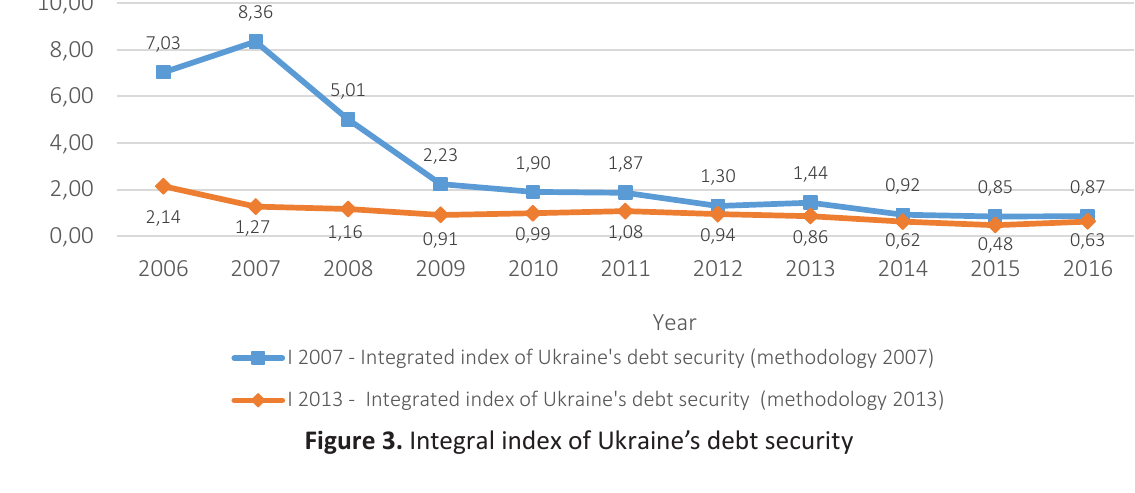
Figure 3. Integral index of Ukraine’s debt